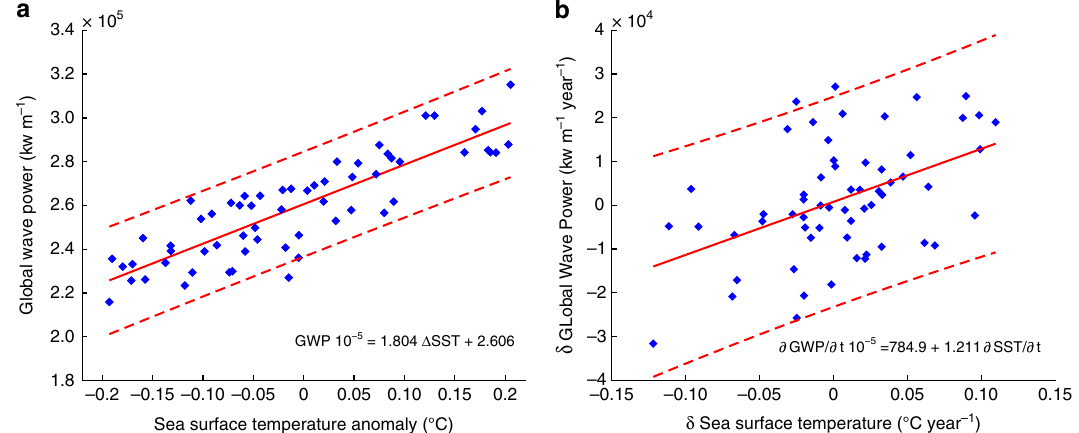
(°C)–0.2 Sea surface temperature anomaly Fig. 5 Regression between the Sea Surface Temperature anomaly and Global Wave Power. a Regression between the global time series of Sea Surface Temperature anomalies (ºC) and Global Wave Power (kw/m); b regression between the annual rates of change in Sea Surface Temperature (ºCyear -1 ) and Global Wave Power (kw m − 1 year − 1 ). The solid red lines represent the linear regression lines (equations are noted in each plot). The red dashed lines represent the 95% con fi dence intervals for each regression line. Both regression lines are statistically signi fi cant at the 95% level. The blue dots represent the data for the period 1948 –